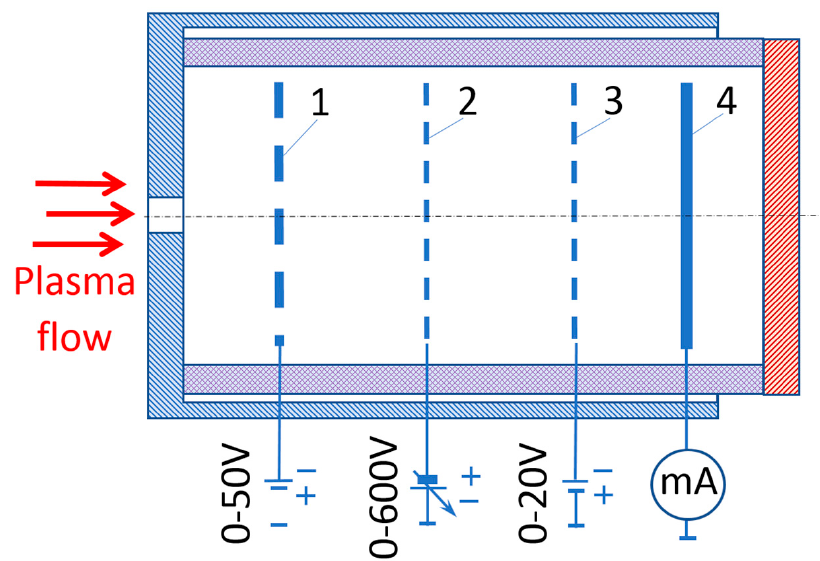
Figure 1. Schematic diagram of multigrid analyzer probe [59]. 1—electron-intercepting grid, 2—analyzing (retarding) grid, 3—antidynatron grid, 4—collector.